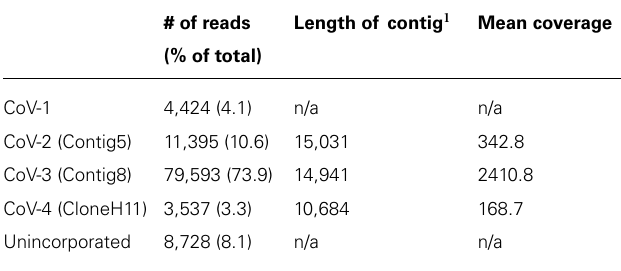
Table 1 | Summary of pyrosequencing results and assembly of reads into contiguous sequences